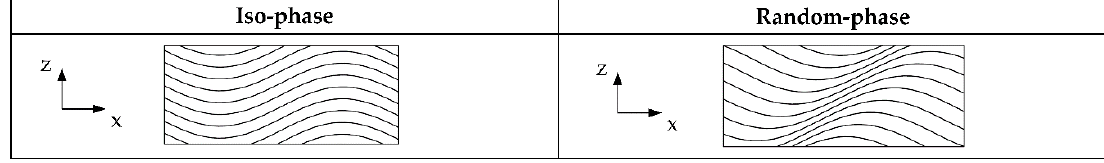
Figure 30. Iso-phase vs. random-phase waviness.